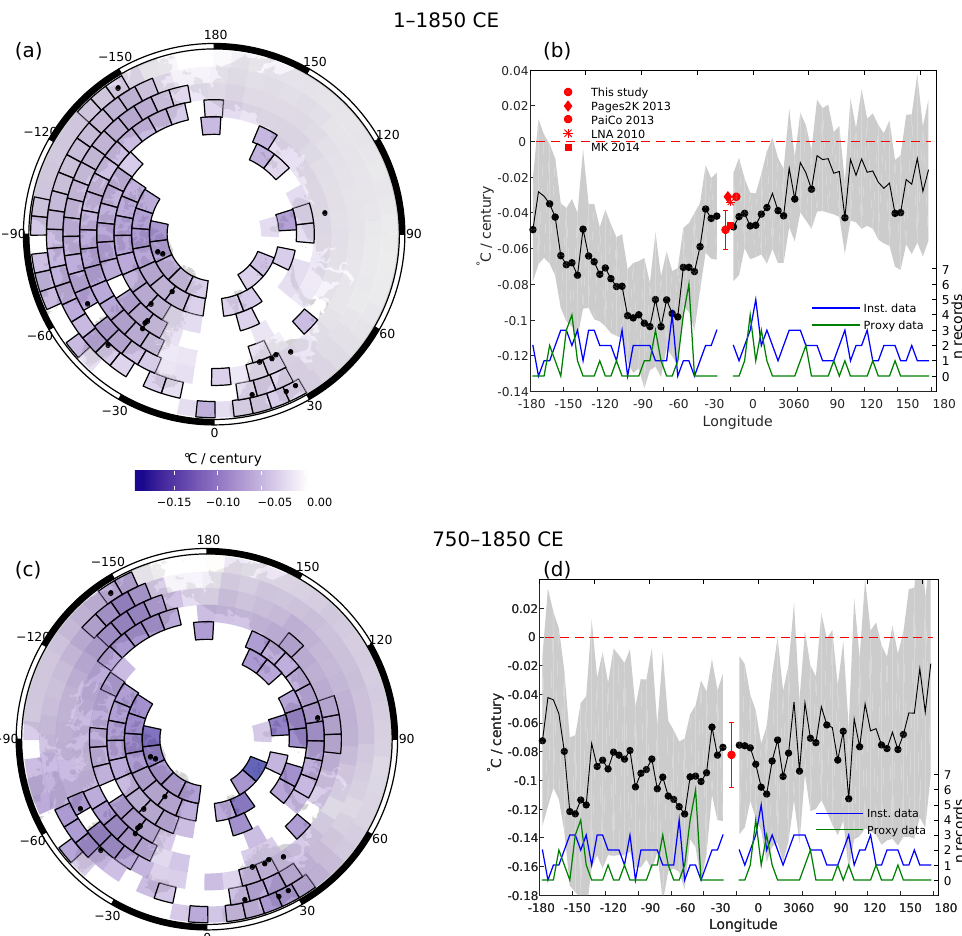
Figure 6. (a) Ensemble-averaged spatial linear trends over the period 1–1850CE in ◦ C per century; black dots mark proxy locations (back to 100CE); quadrilaterals mark locations where the trend is statistically significant for more than 95% of the ensemble members. (b) Ensemble- averaged meridional trends in the latitude-averaged reconstruction over the period 1–1850CE (solid black line); meridional averaging over the 5 ◦ segments and zonal averaging over the terrestrial nodes is applied to each reconstruction ensemble member. Grey shading highlights the 95% uncertainty interval on the estimated trend magnitude derived from the ensemble of spatially averaged reconstructions. Black circles indicate the meridional sectors where the trend is statistically significant. Solid green and blue lines show the number of proxy and instrumental records in each 5 ◦ longitudinal sector. For comparison, the pan-Arctic trend estimates for the same period are shown in red: PAGES 2k Consortium (2013), PaiCo 2013 and LNA 2010 (both: Hanhijärvi et al., 2013), MK 2014 (McKay and Kaufman, 2014), and for this study. Panels (c) and (d) show the analysis repeated for the period 750–1850CE, with the proxies reaching to 750CE marked in (c)